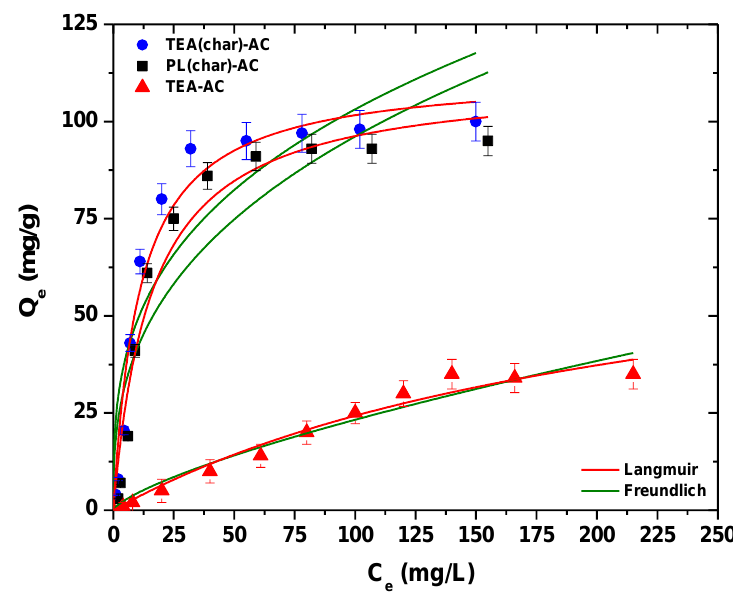
Figure 6. Possible interactions between PRM molecules and activated carbons (ACs).